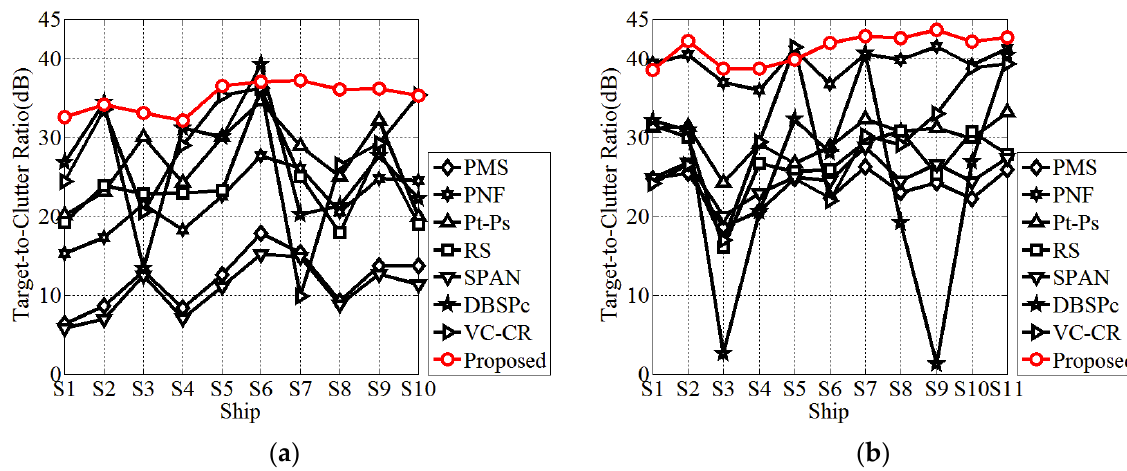
Figure 5. The target-to-clutter ratios for different ship detectors. ( a ) GF3 data. ( b ) AIRSAR data.